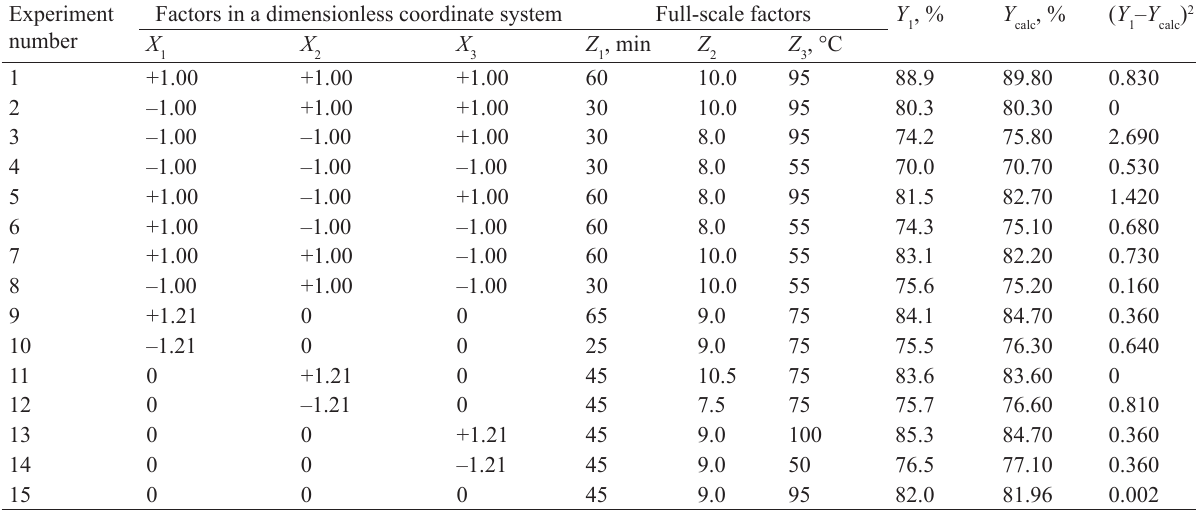
Table 6 Second-order orthogonal design for ostrich fat rendering (k = 3, n